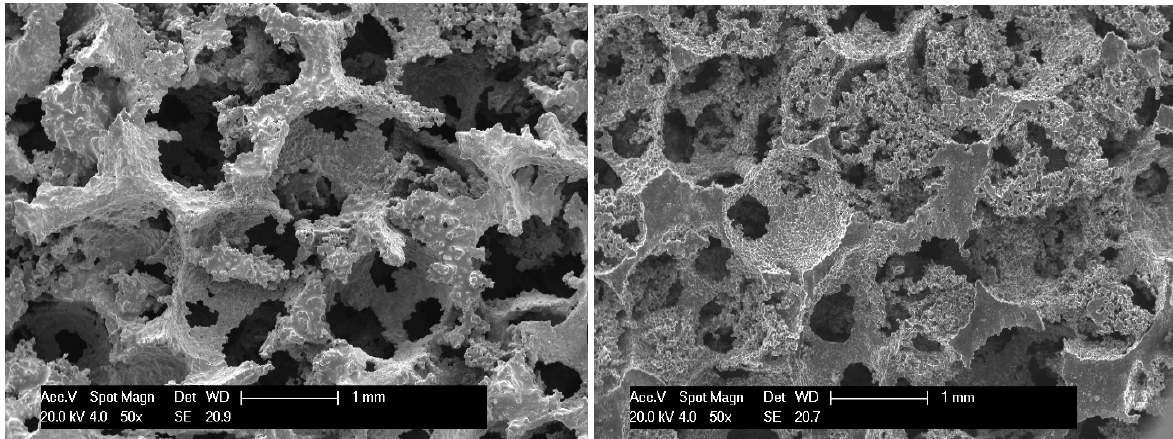
Figure 12. SEM images of foams made by infiltration of salt bead preforms compacted at 50 MPa, (left) at 14 psi and (right) at 36